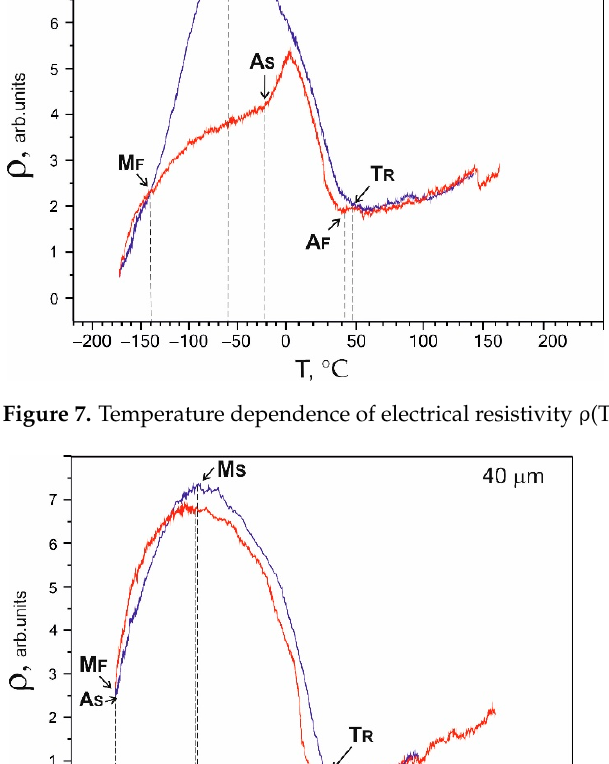
Figure 6. Temperature dependence of electrical resistivity ρ (T) for a 90 µm thick sample.